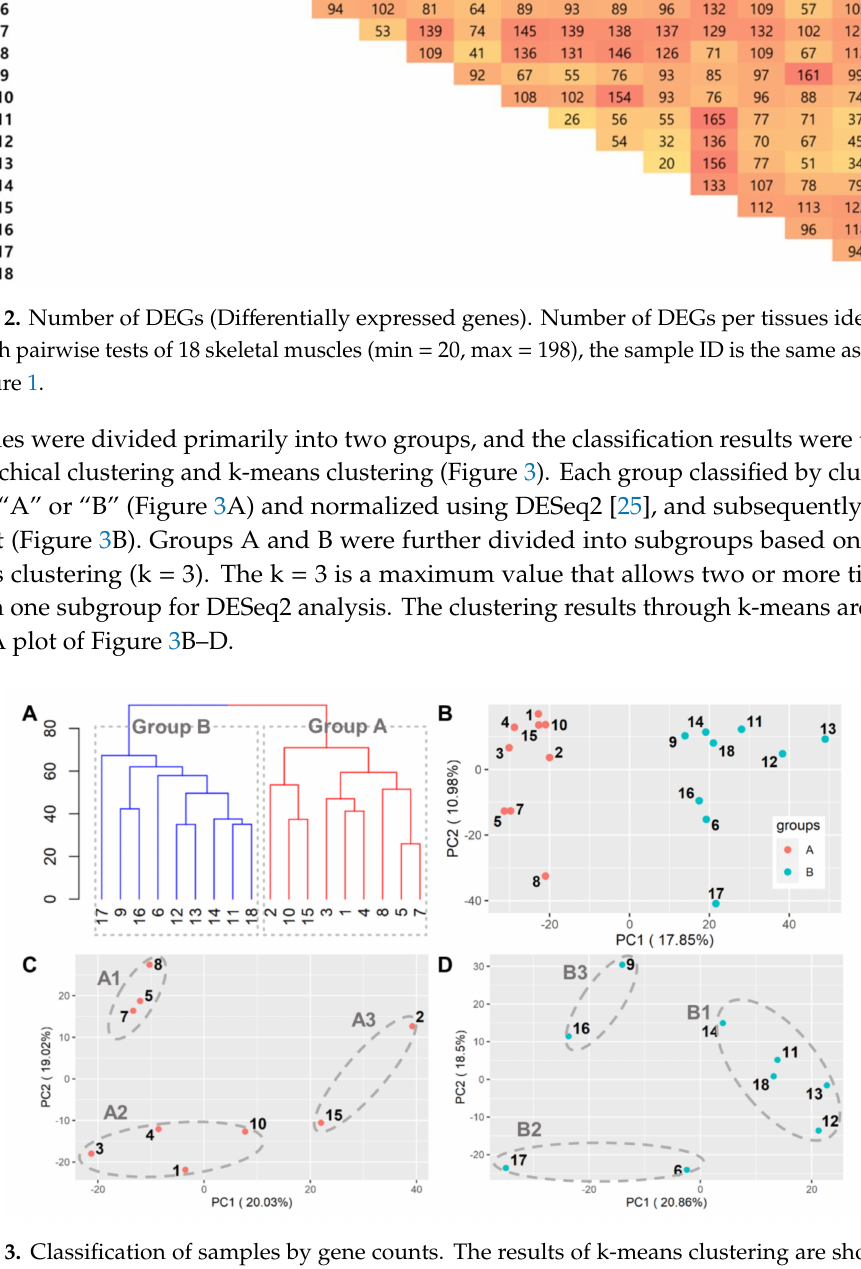
Figure 3. Classification of samples by gene counts. The results of k-means clustering are shown on hierarchical clustering and PCA (Principal component analysis) plot. ( A ) The result of hierarchical clustering using read counts of total DEGs was the same as K-means clustering (k = 2). ( B ) Clustering results for all 18 groups on PCA plot. ( C ) Subgroups in group A by k-means clustering on the PCA plot. ( D ) Subgroups in group B by k-means clustering on the PCA